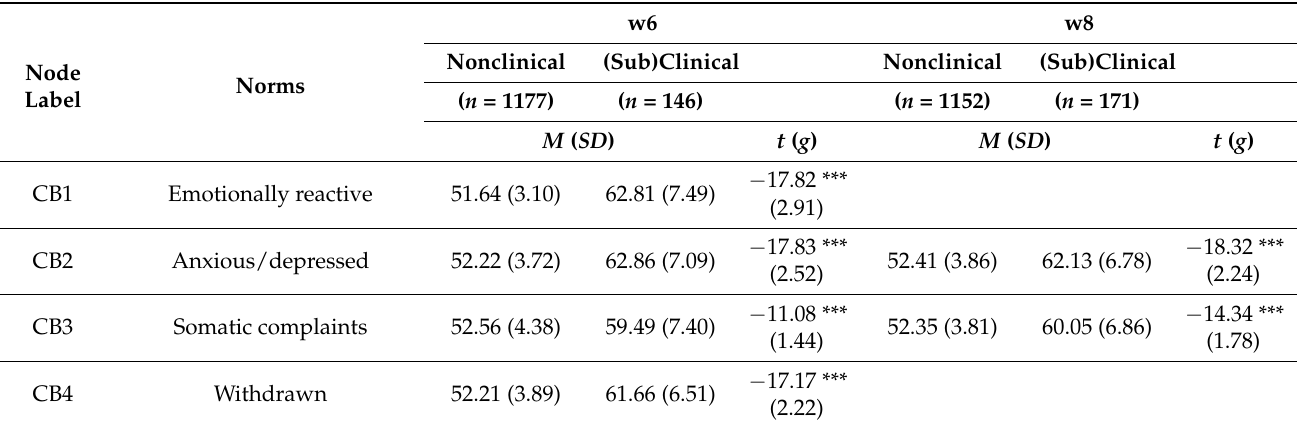
Table 2. Mean difference of CBCL behavior problems (T-score) between nonclinical and (sub)clinical groups and mean edge weight of network by